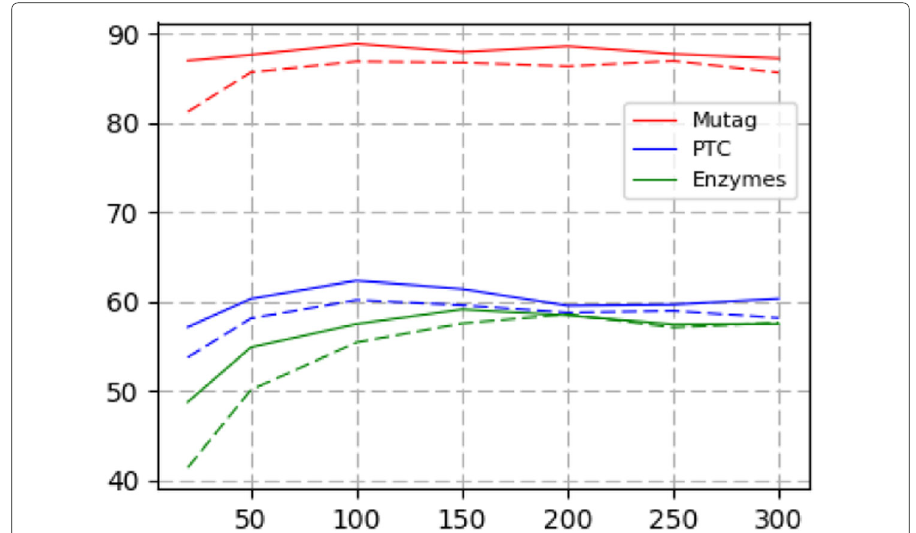
Fig. 8 Representation dimensionality ( x axis) vs classification accuracy ( y